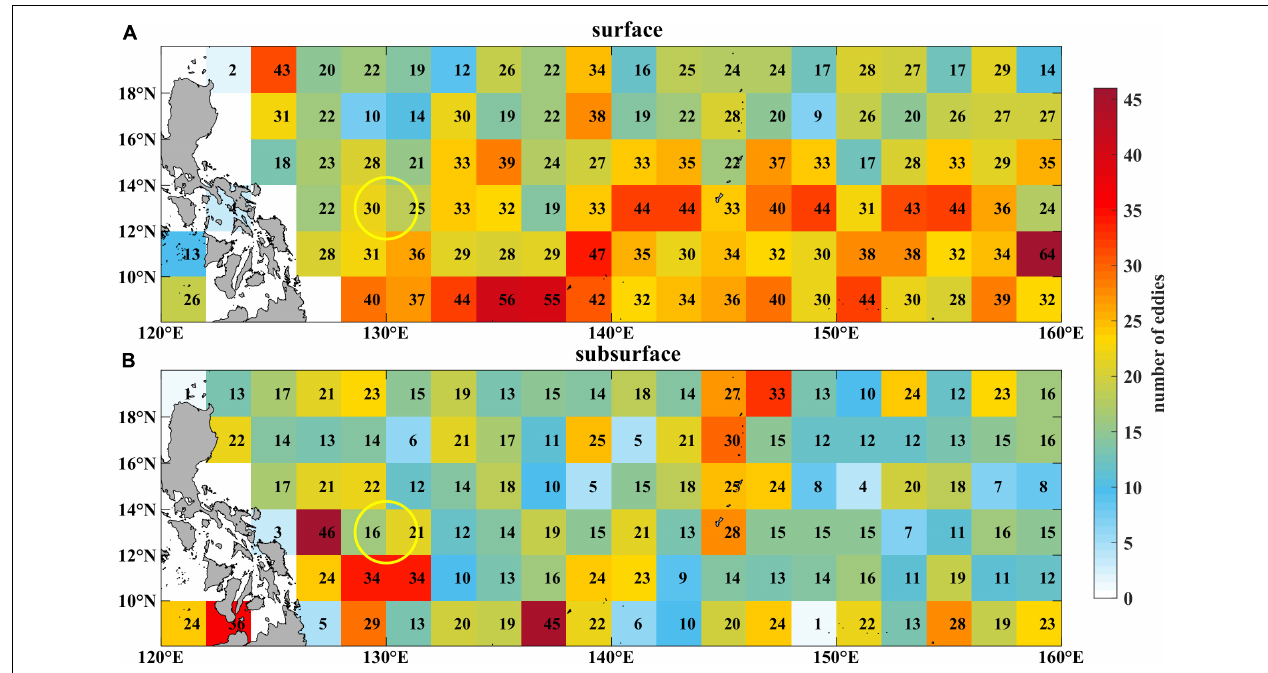
FIGURE 8 | (A) Geographic distribution of the generation number of surface eddies in each 2 × 2 box based on eddy trajectory analysis using 6 years of AVISO data (2010–2016). (B) same as (A) , but for subsurface eddies using OFES outputs in the same period. The yellow circle denotes the region centering at the mooring location with a radius of 150 km.